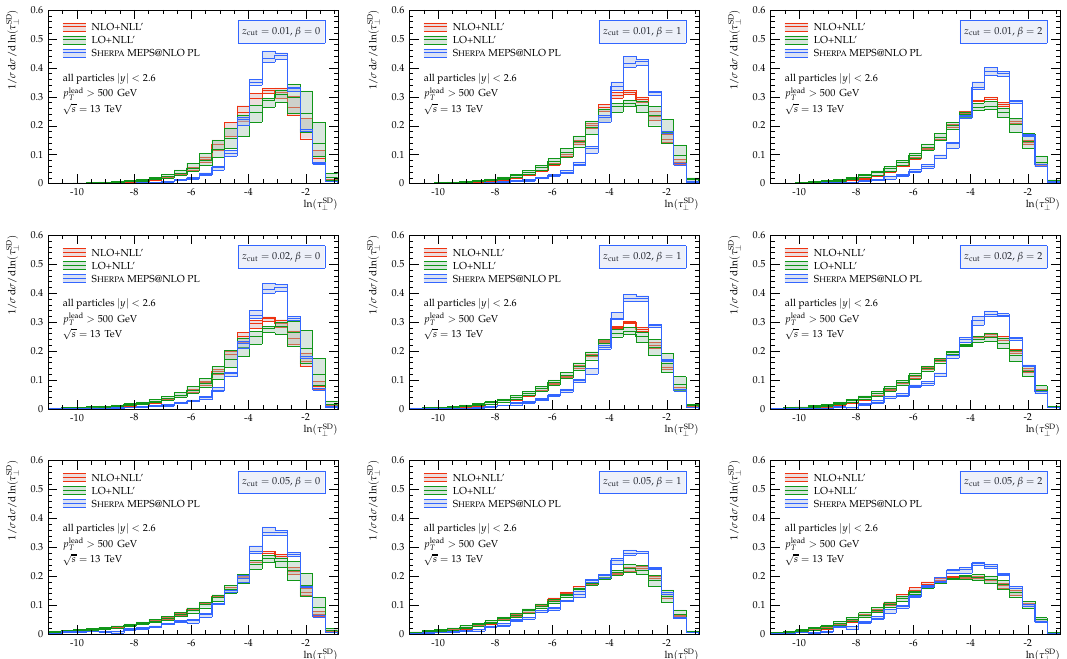
Figure 20 . Comparison of NLL resummed results matched to LO and NLO and MEPS @ NLO parton-level predictions from S HERPA for groomed transverse thrust for β ∈ { 0 , 1 , 2 } (columns) and z cut = 0 . 01 , 0 . 02 , 0 . 05 (rows) for the p T, min = 500 GeV event